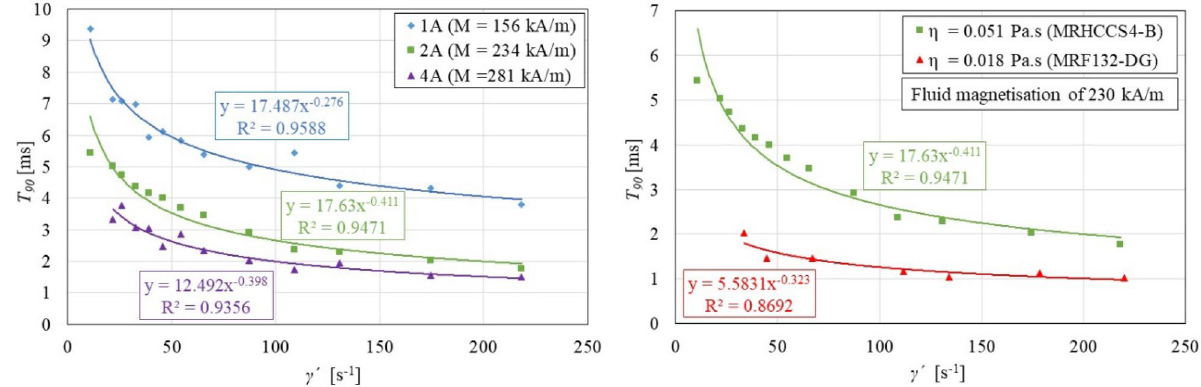
Figure 6. The effect of magnetization M (left) and carrier fluid viscosity η (right) on response time T 90